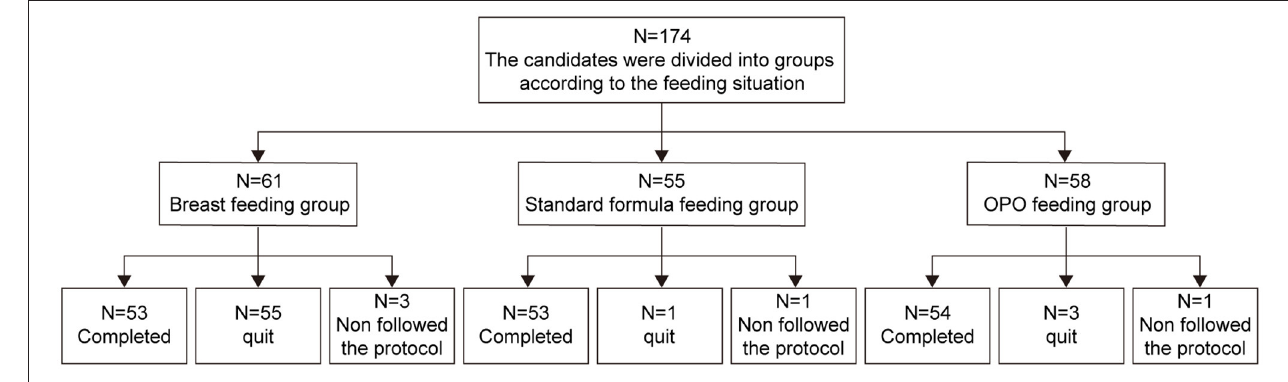
FIGURE 1 | Study flow diagram.